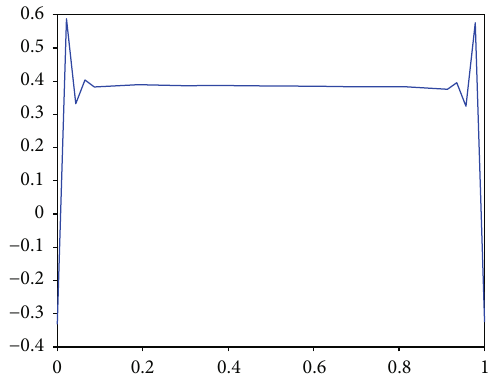
Figure 4: Line graph at N = 2 4 , Δ t = 0 : 1/2, ε = 2 − 12 , λ = − 0 : 55